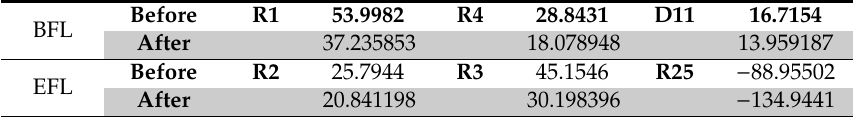
Figure 4. Optical layout after combining the optical layout of JP20160012034A2P and the optical layout of KR1020140124286AP. Table 2. Combined optical layout BFL and EFL change value before and after correction.